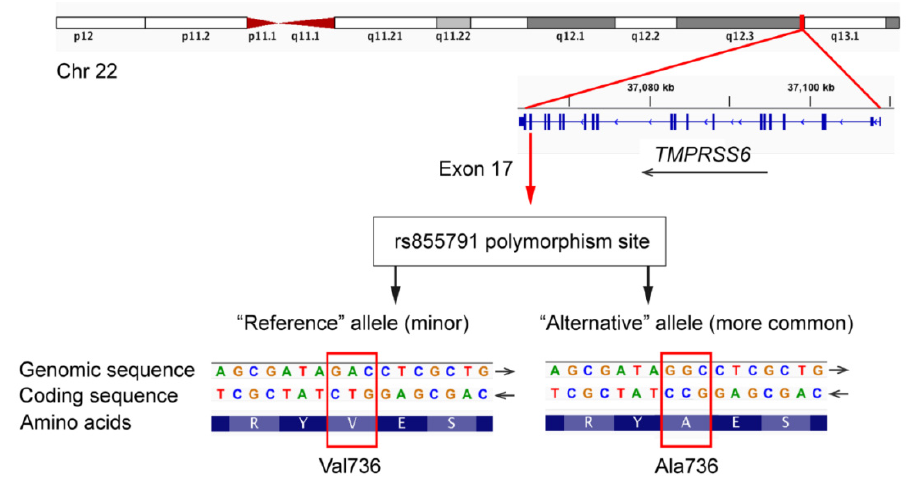
Figure 5. Schematic representation of the rs855791 polymorphism.